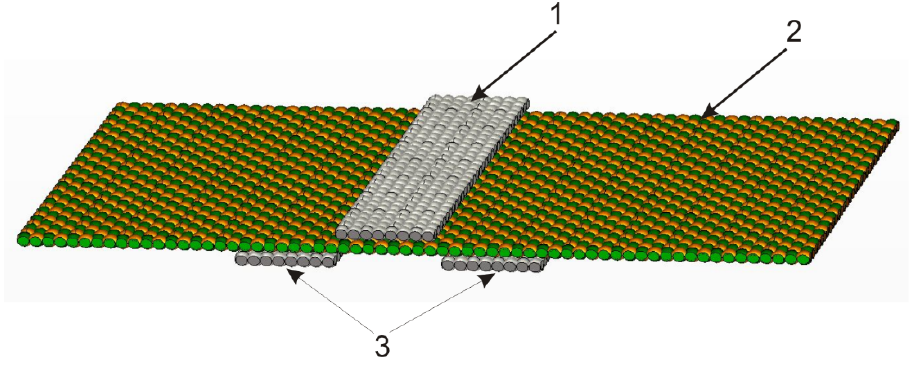
Figure 1. The construction of the tested lines.